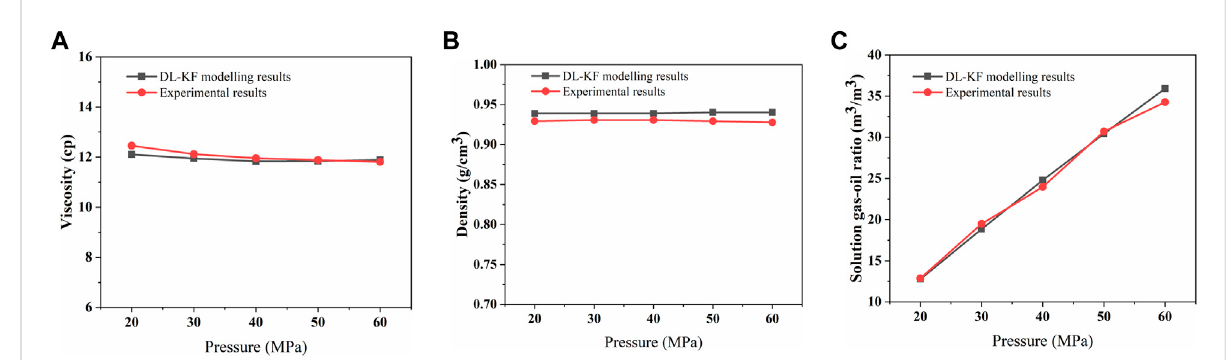
FIGURE 11 Calculationresultsoftheviscosityofliquidphase (A) ,thedensityofliquidphase (B) andthesolutiongas-oilratio (C) comparedbetweentheDL- KF modeling and